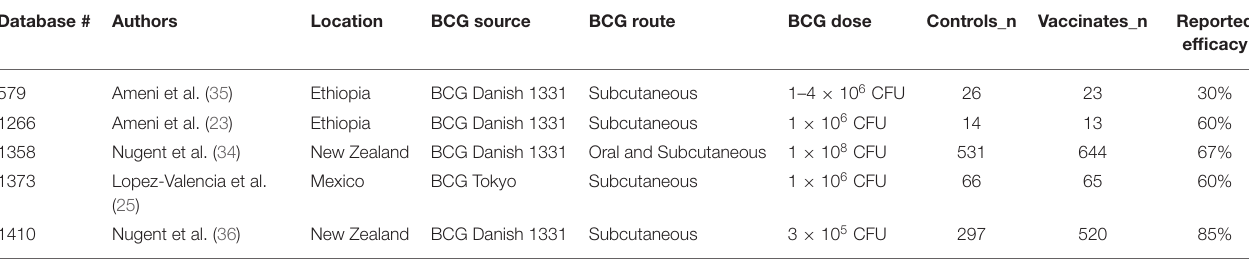
TABLE 3 | Natural transmission studies included in the